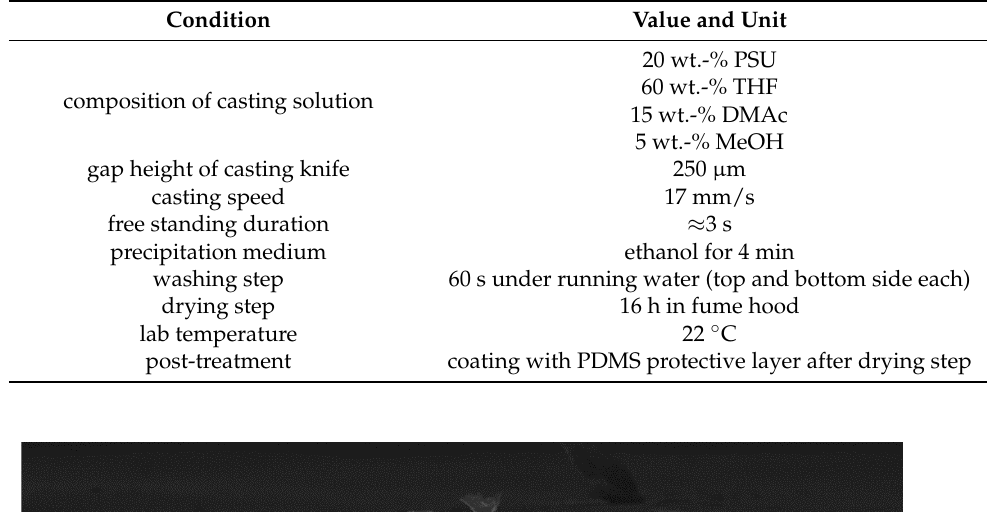
Table 1. Fabrication conditions for PSU flat sheet membranes.